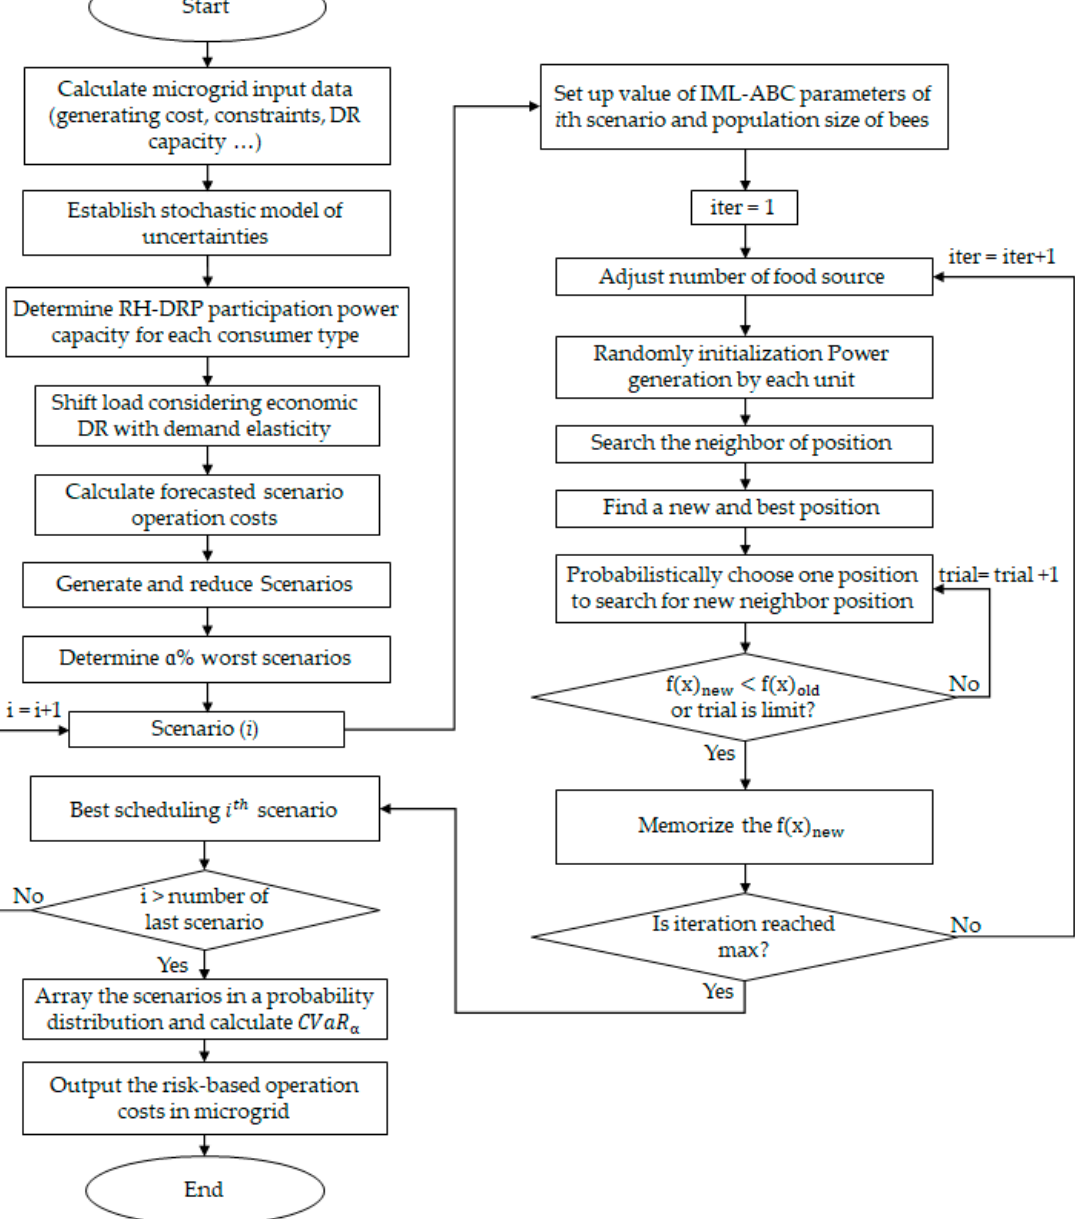
Figure 3. Overall process of the proposed optimal operation approach.